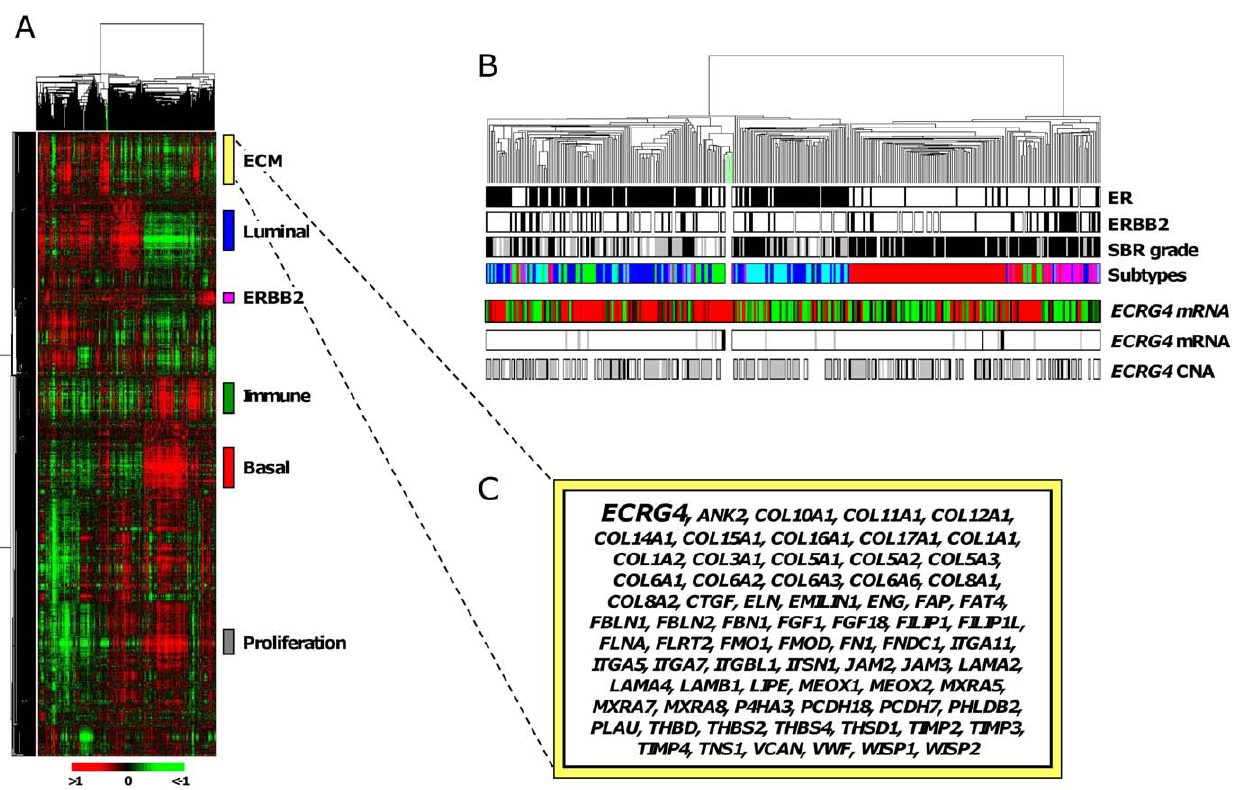
Figure 1. mRNA expression of ECRG4 in breast cancer. (A) Thumbnail of the hierarchical clustering of the 353 breast cancers and 4 NB samples (columns) and the 12,304 most variable genes (rows). According to a log 2 pseudocolor scale (bottom), red indicates a high level of mRNA expression compared to the median value across all samples, whereas green indicates a low level of expression. The magnitude of deviation from the median is represented by the colour saturation. The dendrogram of samples (above matrixes) represents overall similarities in gene expression profiles and is zoomed in B. Green branches indicate the 4 NB samples. To the right of the color matrix, are represented some biologically relevant gene clusters. The extra-cellular matrix (ECM)-related cluster, which includes ECRG4 , is detailed in C. (B) Samples dendogram. Green branches indicate the 4 NB samples. Under the dendogram are reported some histo-clinical tumor features colored as below: ER IHC status (white, negative, and black, positive); ERBB2 IHC status (white, negative, and black, positive); SBR Grade (white, 1, grey, 2; and black, 3molecular subtypes (dark blue, luminal A, light blue, Luminal B, pink, ERBB2, red, basal-like, and green, normal-like). Some molecular features regarding ECRG4 are represented below: mRNA expression level (median-centered and color-coded as in A), expression status as compared to NB (overexpression, black, neutral, grey, and underexpression, white), and aCGH-based copy number alteration (CNA: gain, black, neutral, grey, and loss, white). (C) Details of the genes belonging to the ECM gene